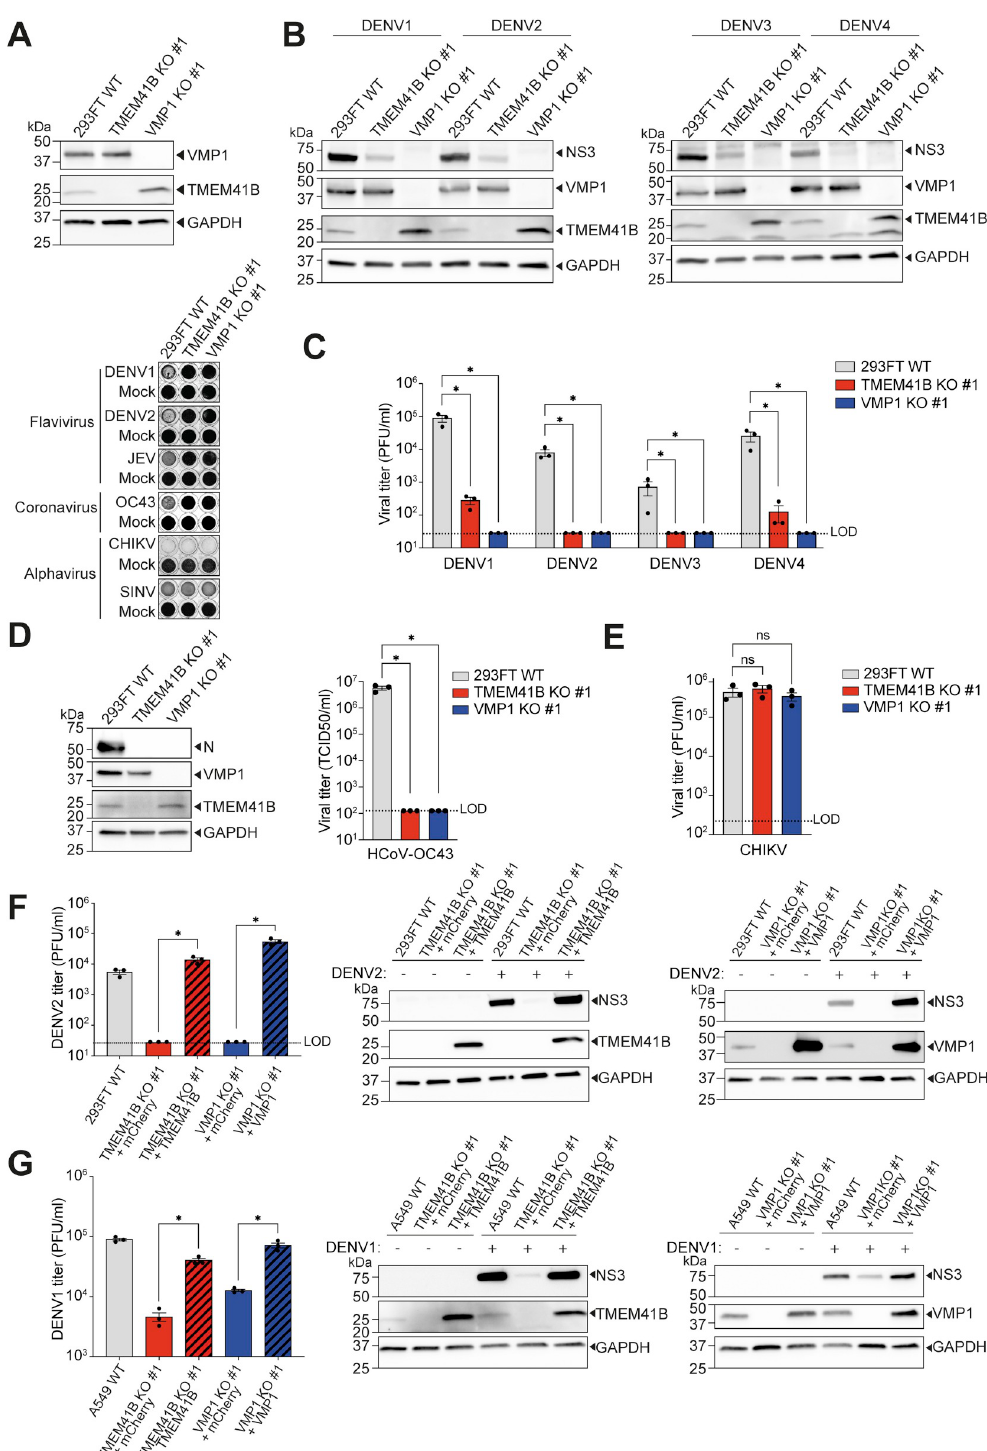
Fig 1. TMEM41B and VMP1 are host dependency factors for flaviviruses and human coronaviruses, but not alphaviruses. (A) Multiple rounds of virus infection in 293FT WT, TMEM41B KO clone #1, and VMP1 KO clone #1 cells. (Top) Western blotting analysis to detect TMEM41B and VMP1 protein levels in the WT and KO cells. (Bottom) Crystal violet staining to visualize surviving cells after cytolytic virus infection. Non-infected controls are indicated as “mock”. (B, C) Validation of TMEM41B and VMP1 as host dependency factors across all DENV serotypes. For (B), cells were infected